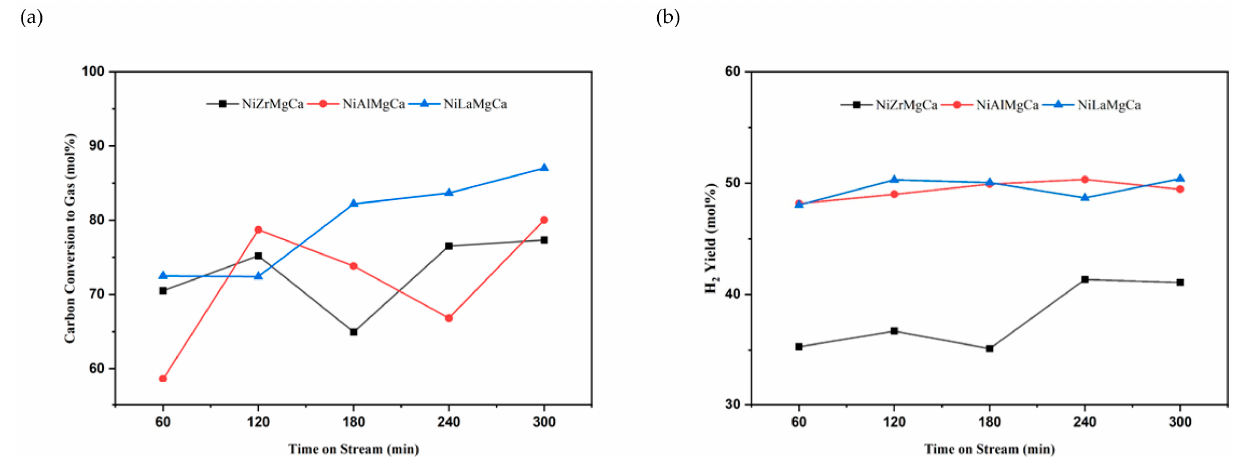
Figure 8. ( a ) Carbon conversion to gas for 5 h experiment; ( b ) hydrogen yield production for 5 h experiment (reaction condition: temperature = 800 °C; S/C ratio = 1; GHSV = 13,500 h − 1 ).